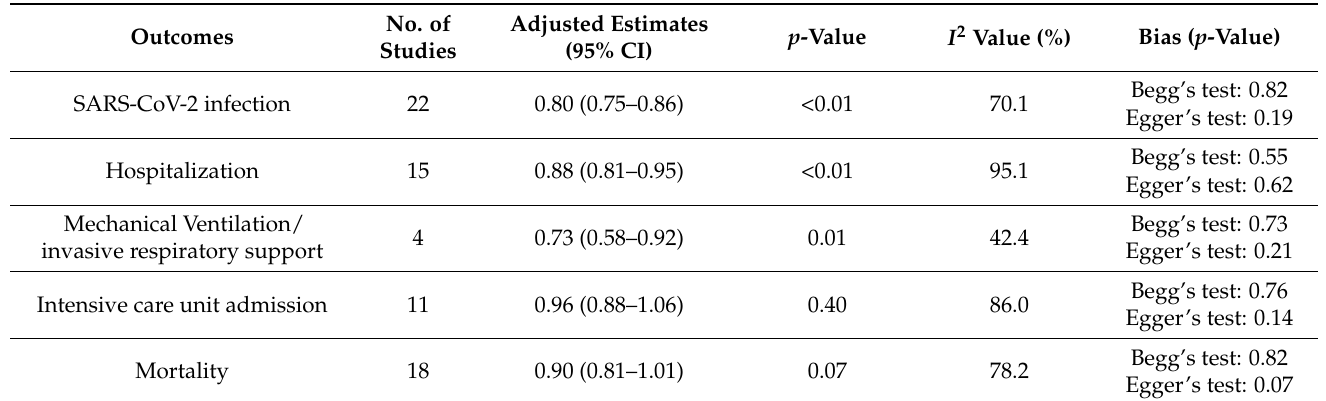
Table 4. Effect sizes, heterogeneity statistics and results for publication bias on the association between influenza vaccination, SARS-CoV-2 infection as well as clinical